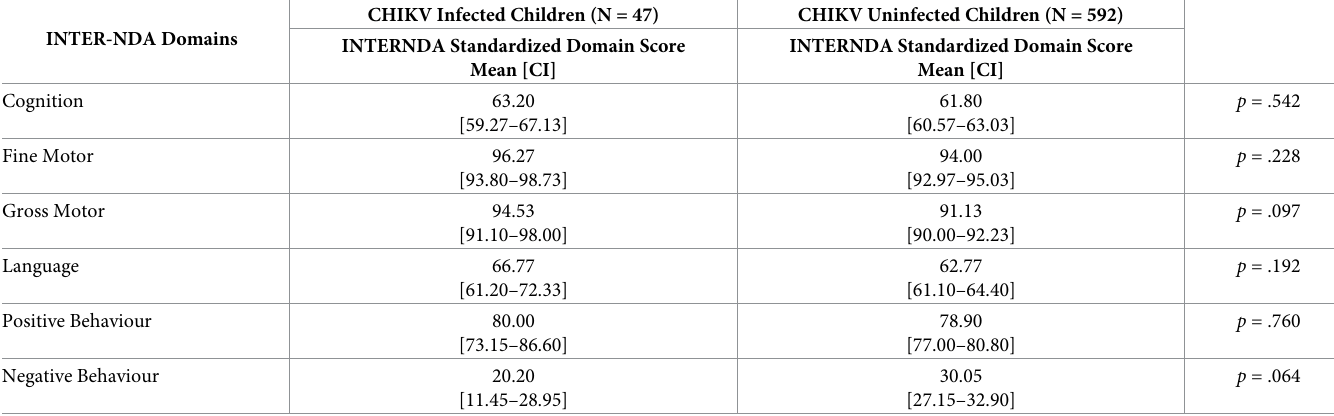
Table 7. Mean differences on standardized INTER-NDA domain scores between CHIKV infected vs. CHIKV uninfected children. INTER-NDA Domains